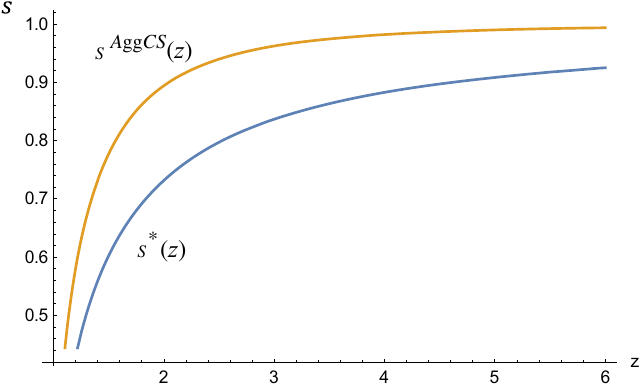
Fig. 7 Sizes of the buyer group that maximize aggregate consumer surplus and per-member consumer surplus for different values of parameter